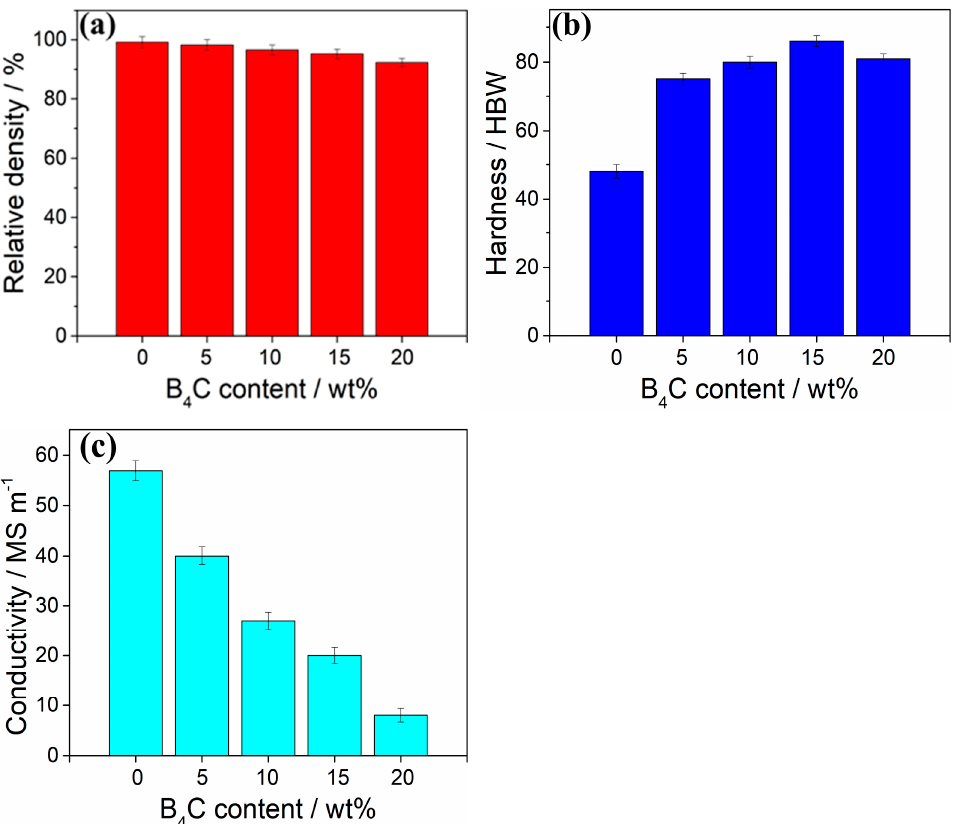
Figure 6. The relative density, hardness and conductivity of B 4 C/Cu composites with different amounts of B 4 C: ( a ) relative density; ( b ) hardness; ( c ) conductivity.